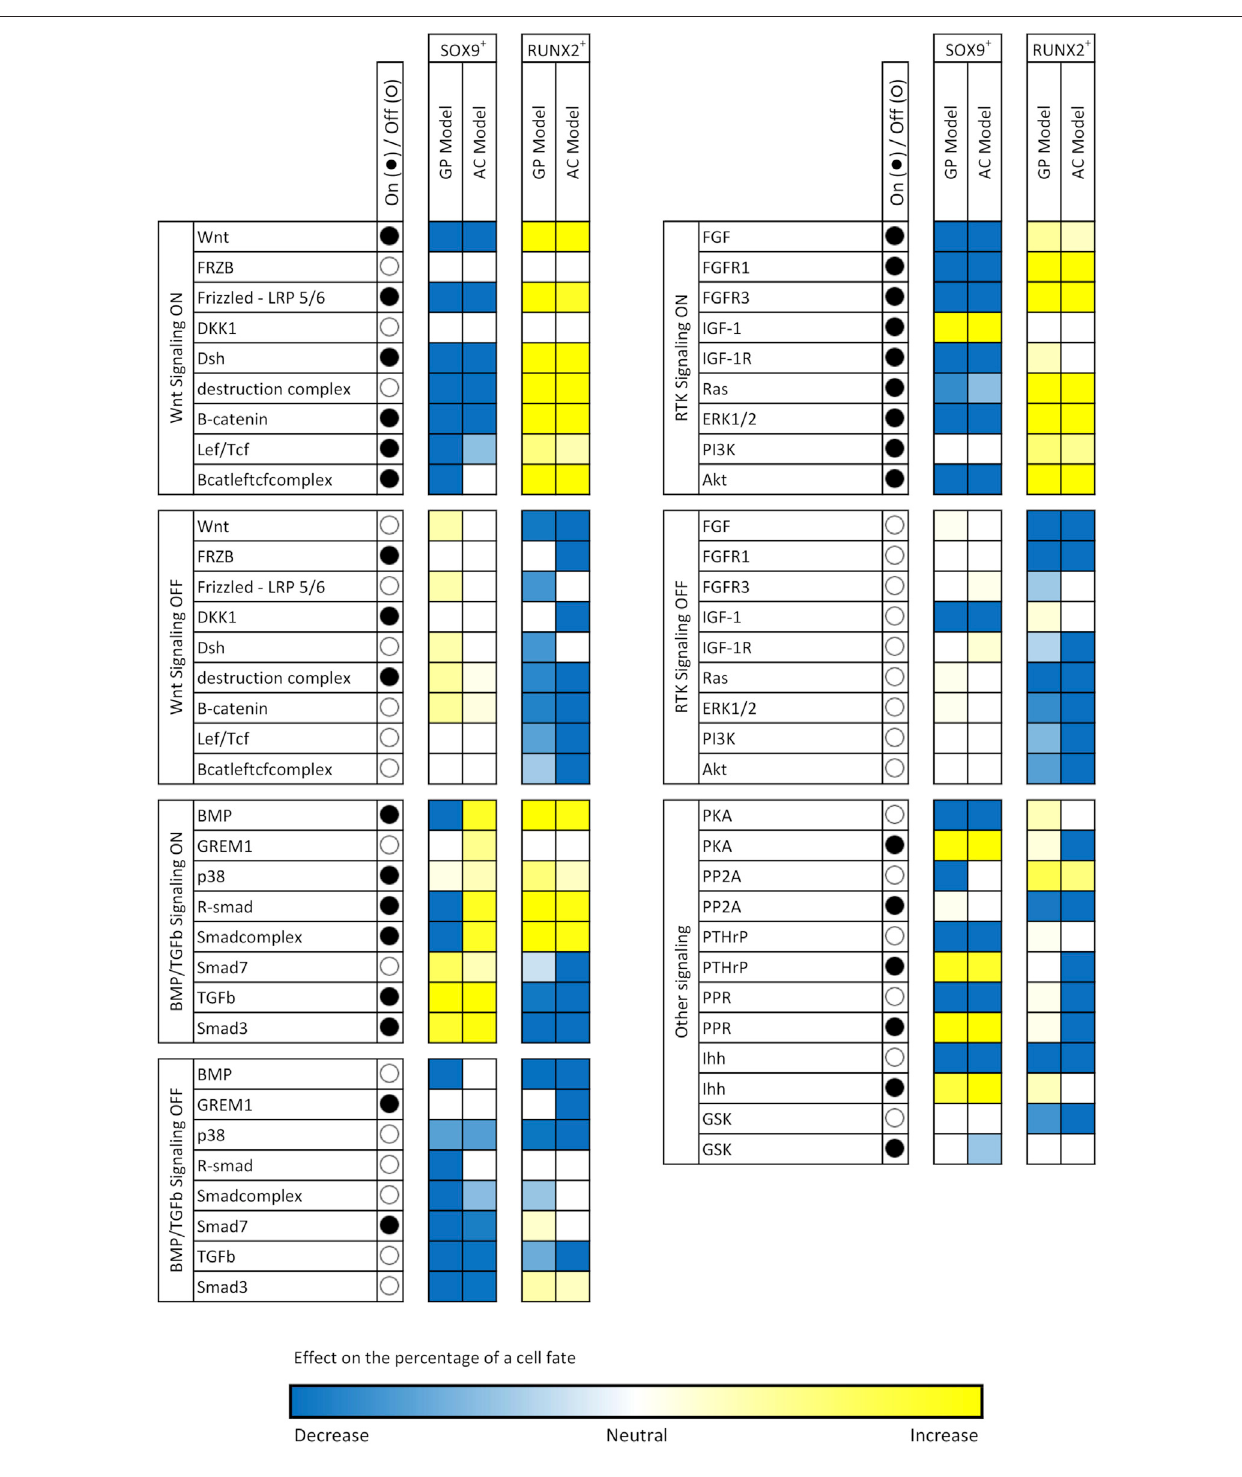
Frontiers in Bioengineering and Biotechnology |